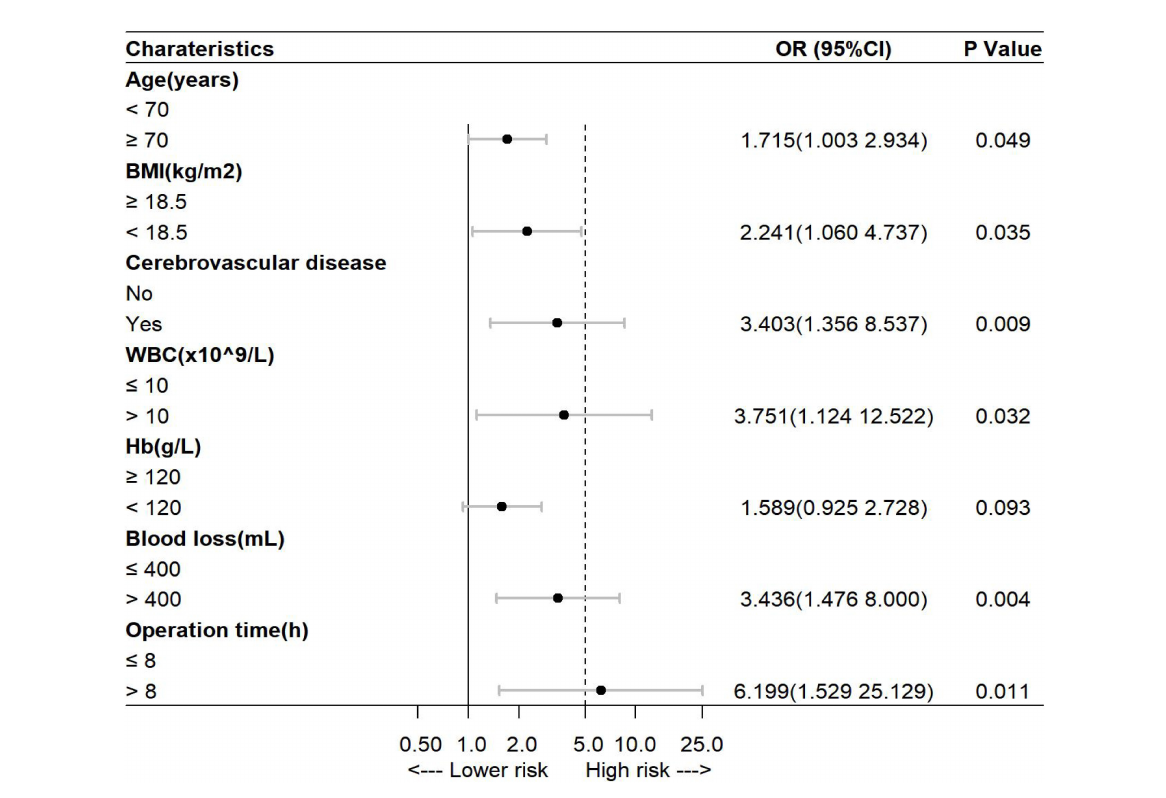
FIGURE1 Multivariate analysis of the risk of postoperative cognitive dysfunction (POCD) in elderly patients undergoing gastrointestinal tumor resection. BMI, body mass index; WBC, white blood cell; Hb,